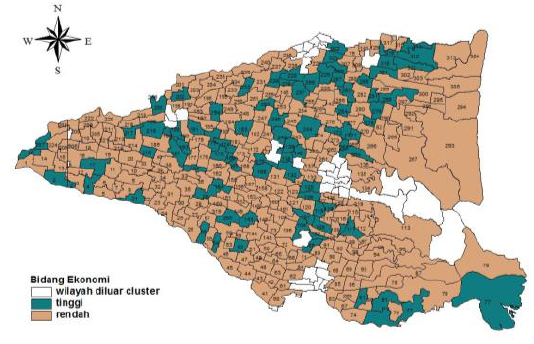
Figure 1: Village mapping based on Economic